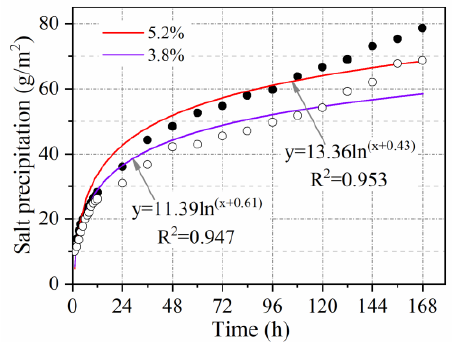
Figure 13. Effect of void ratio on salt precipitation.